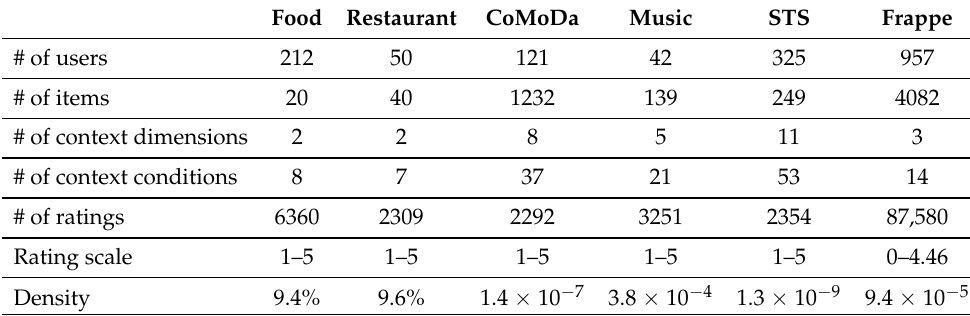
Table 4. List of Contextual Data